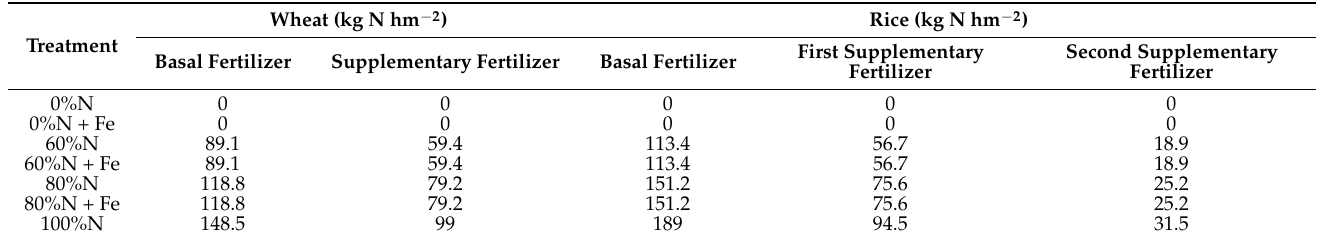
Table 1. Treatments and fertilization rate in the field